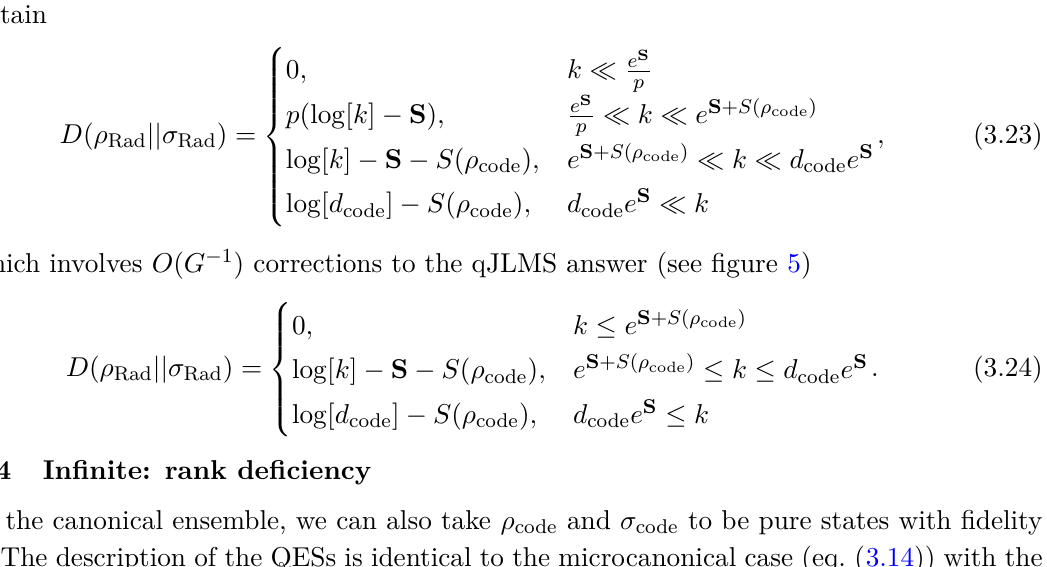
Figure 5 . A sketch of the relative entropy (black line) for the microcanonical ensemble with σ code being the maximally mixed state in the code subspace and ρ (cid:0) (cid:1) correction only occurs at the first O G − 1